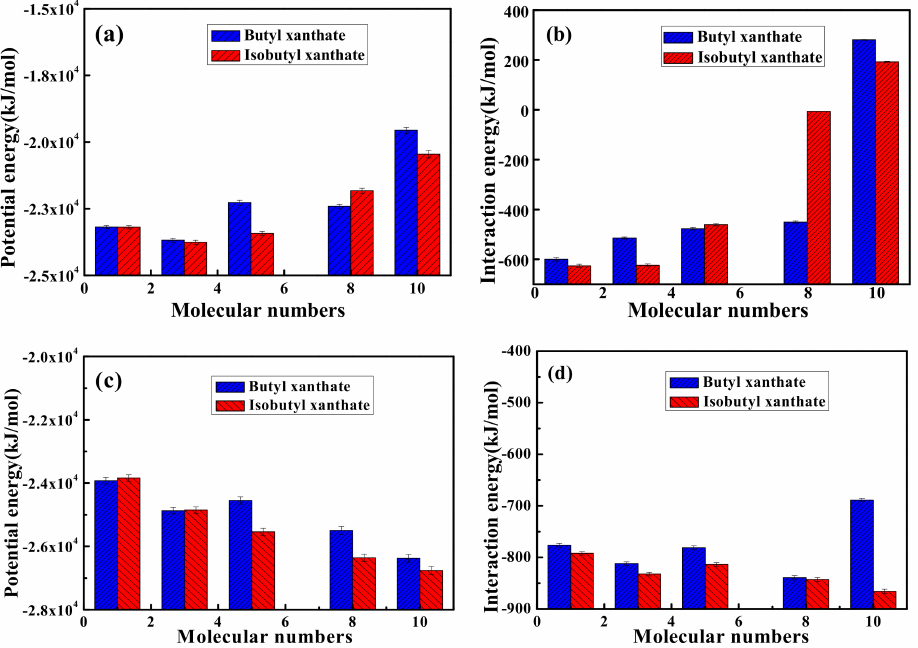
Figure 9. Potential and Interaction energies between pyrite surface and xanthate solution for NVT ( a , b ) ensemble or NPT ( c , d )